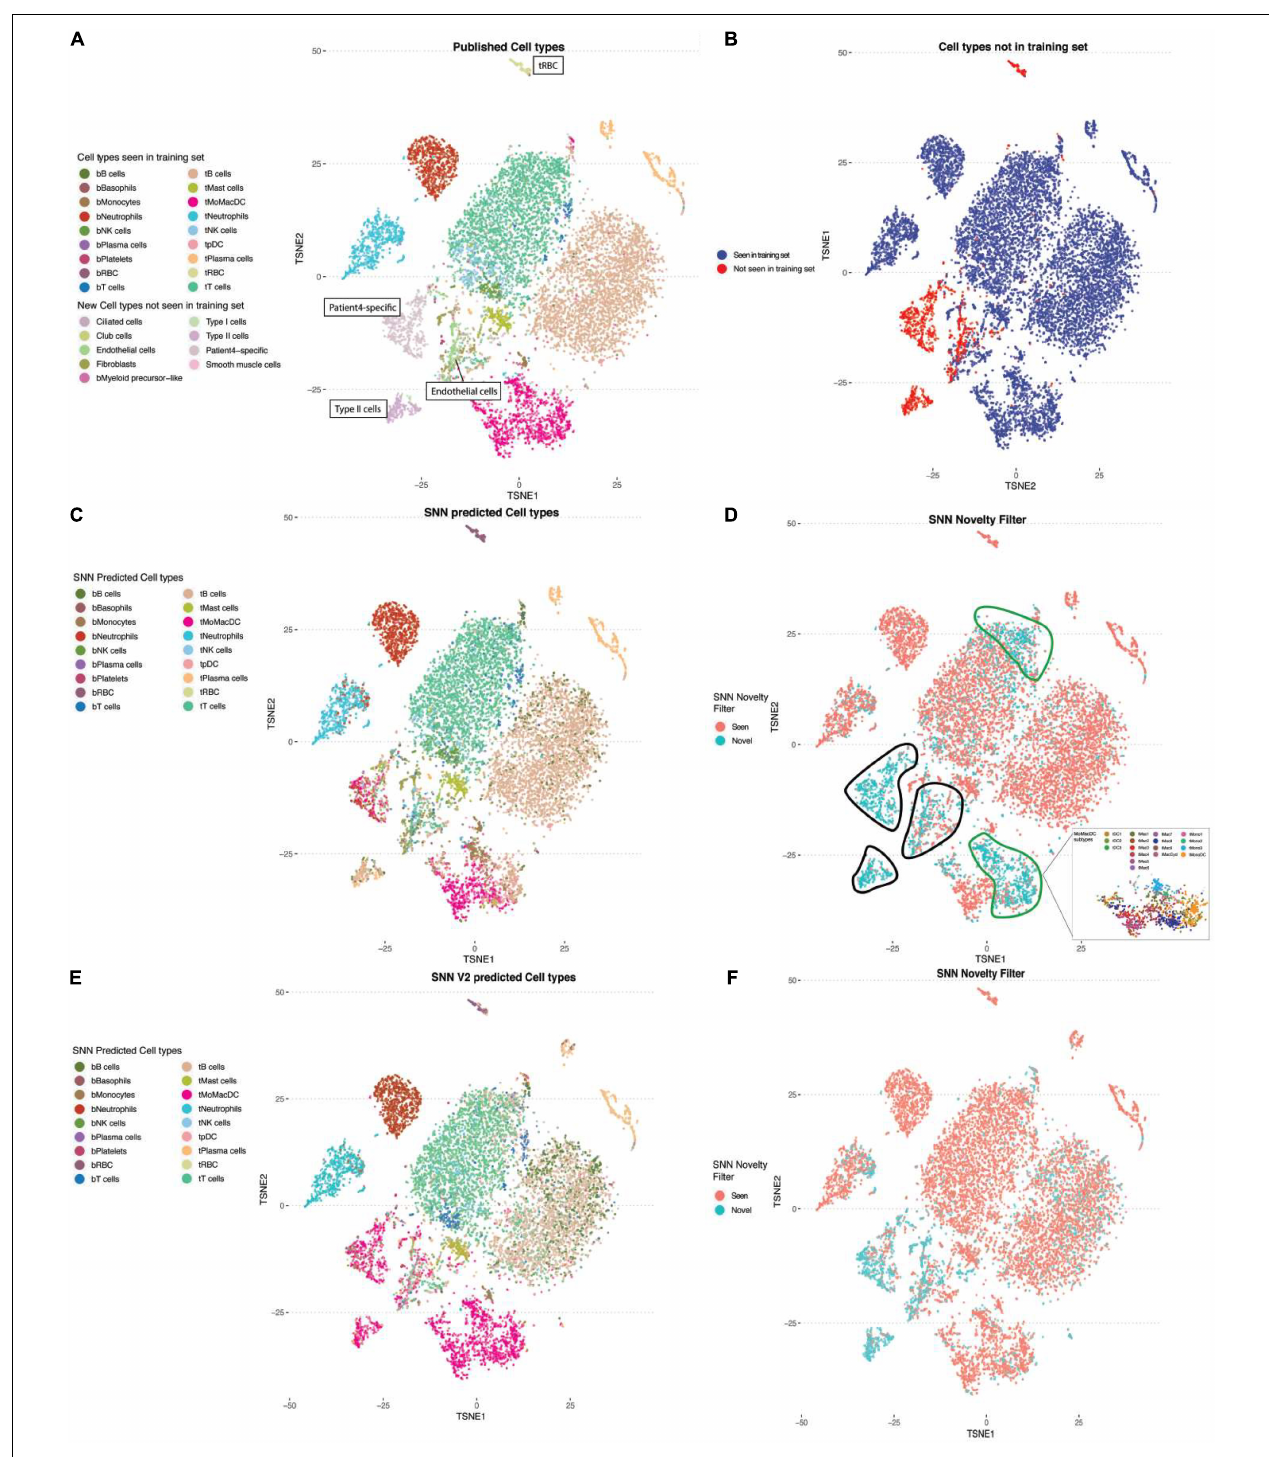
FIGURE 4 | Using Siamese Neural Network (SNN) distance for novelty detection. (A) TSNE plot of single-cell RNA-seq NSCLC sample colored by cell types. Cell types not present in the training data set are labeled in boxes (tRBC, patient-4 specific cells, endothelial cells, Type II cells). (B) TSNE plot of the same data. Highlighted in blue and red are the cells which were classified as cell types found and not found in the training set, respectively. (C) TSNE plot colored by SNN predicted cell types. (D) TSNE plot colored by SNN novelty filter. Cells marked by black outline are flagged as novel cells not seen in training set. Cells marked by green lines are flagged as novel cells seen in training set. Callout box are the MoMacDC cluster colored by annotated subtypes. (E) TSNE plot colored by cell-type classification after re-training to include different sub-celltypes from MoMacDC cluster. (F) TSNE plot color by SNN novelty filter after re-training with sub-celltype MoMacDC